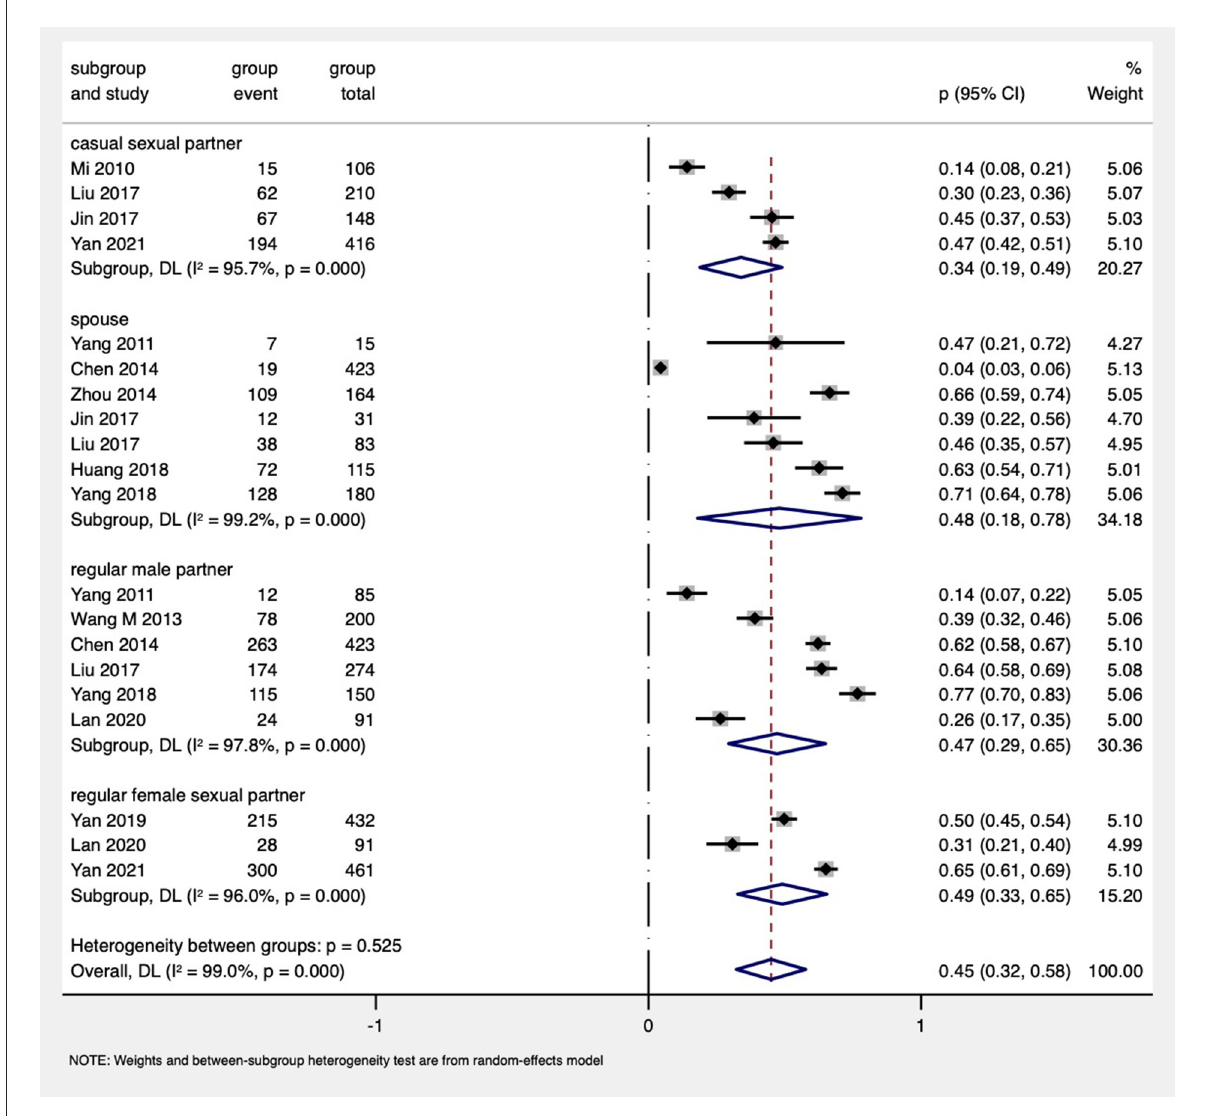
FIGURE5 Forest plot of subgroup analysis by types of sexual partners among MSM